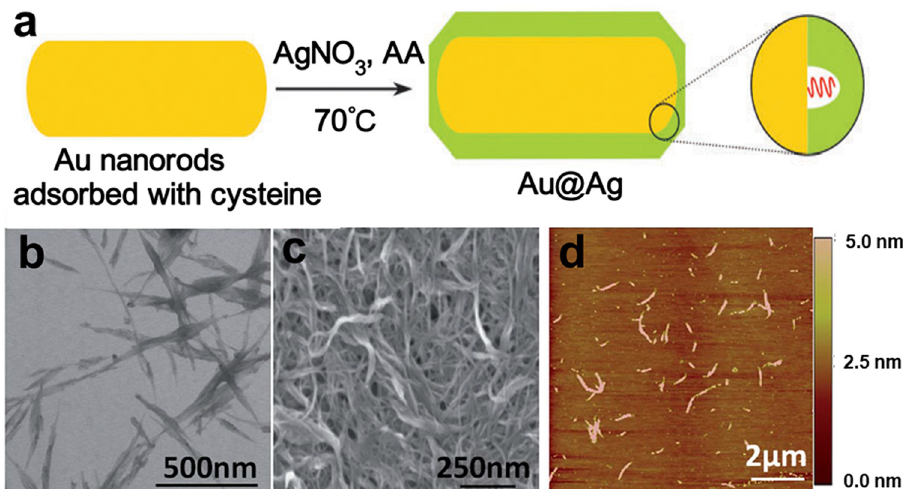
Figure 8: ( a ) Schematic of the preparation method. ( b – d ) STEM, SEM, and atomic force microscopy ( AFM ) images of SWNT/PL – PEG – COOHs, respectively. Reproduced with permission [ 164 ] . Copyright 2016, Springer Nature. ( b – d ) STEM, SEM, and AFM images of SWNT/PL – PEG – COOHs, respectively. Reproduced with permission [ 165 ] . Copyright 2016, Royal Society of